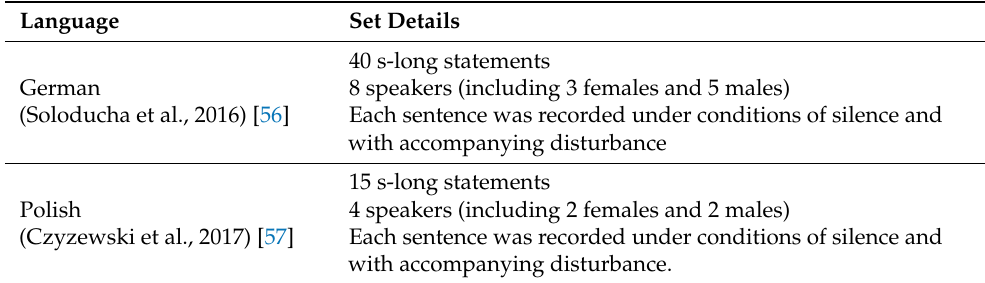
Table 1. Sets of recordings used for training and